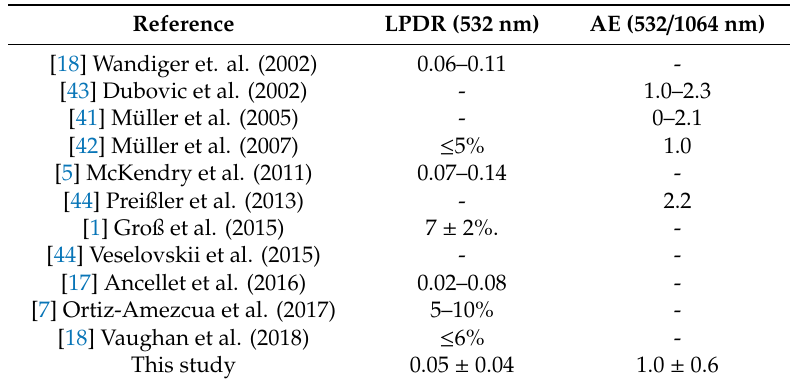
Table 2. Optical properties of smoke aerosols measured during Canadian and North American biomass burning events, as cited in the relevant literature